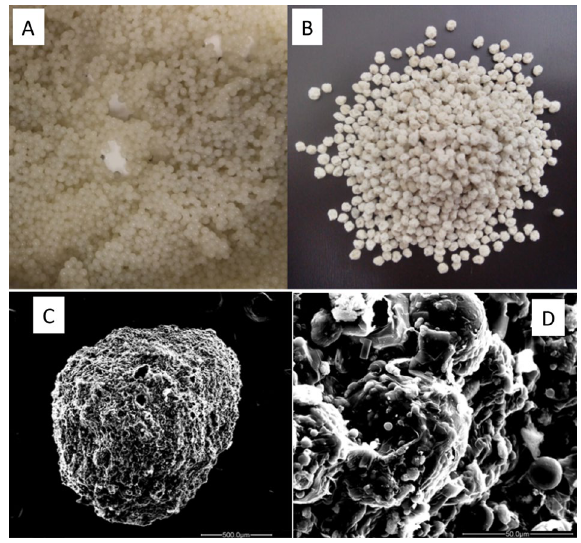
Figure 2. Alginate/clay beads (i.e., granules) containing PCL-PBZ microparticles. The granules are shown before ( A ) and after ( B ) lyophilization. SEM images of the beads at low magnification ( C , scale = 500 µm) and at high magnification ( D , scale bar = 50 µm).